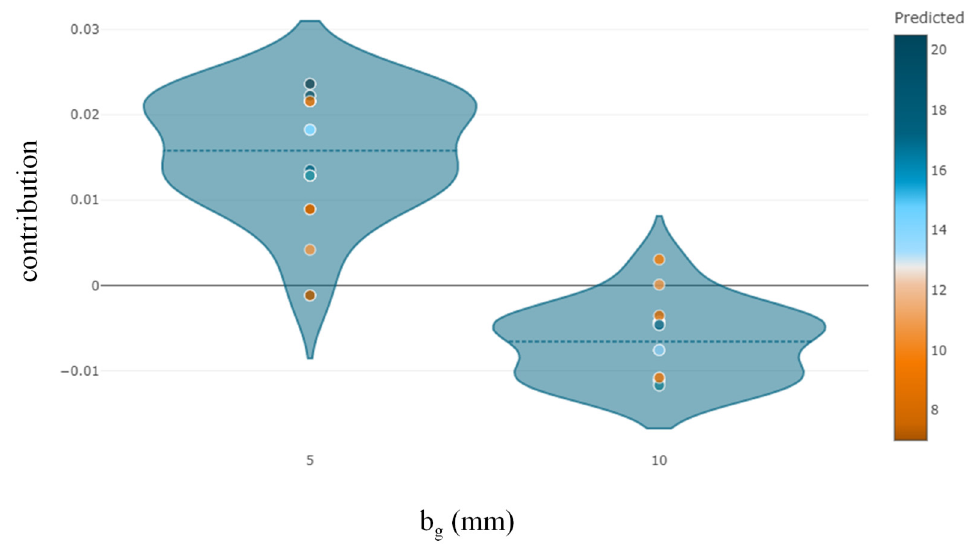
Figure 11. Feature contribution of b g towards the target variable.